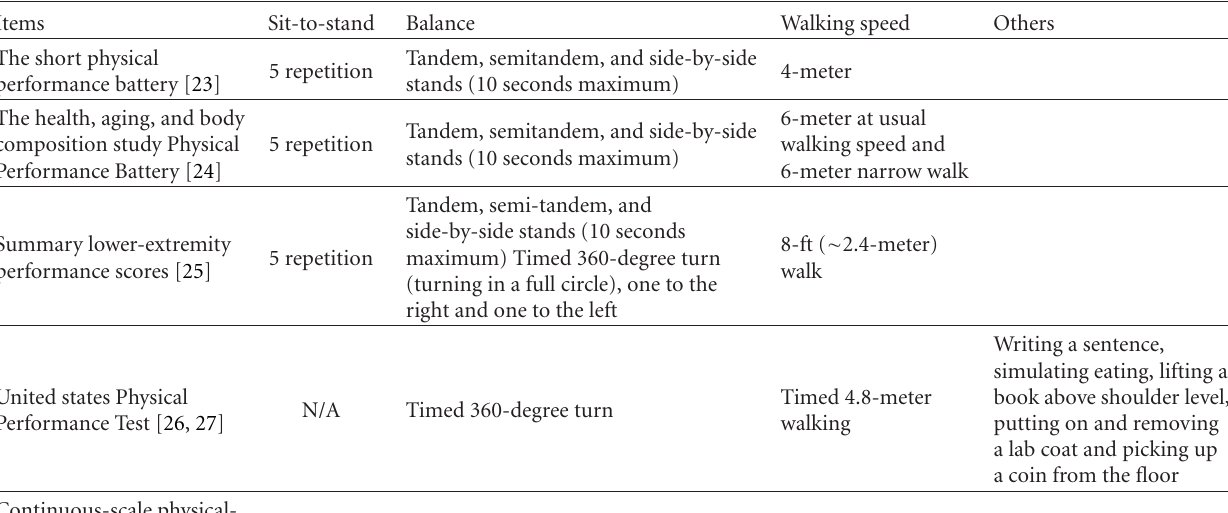
Table 3: Summary of instruments for physical performance (PP)